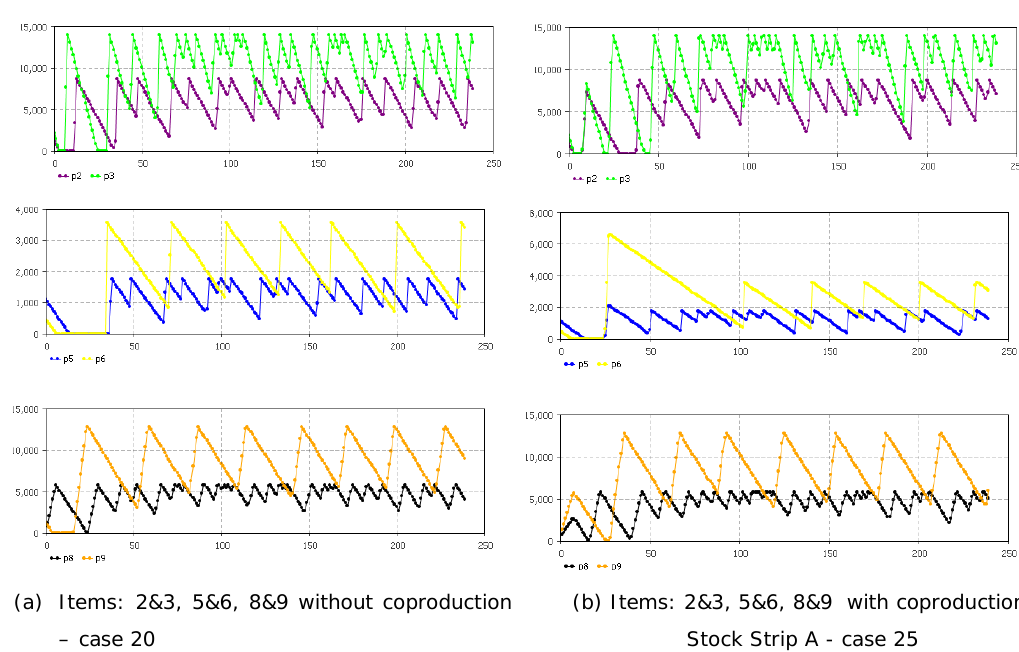
Figure 3. “Impact of Coproduction addition on the stocks in the Fransoo scheduling rule”.